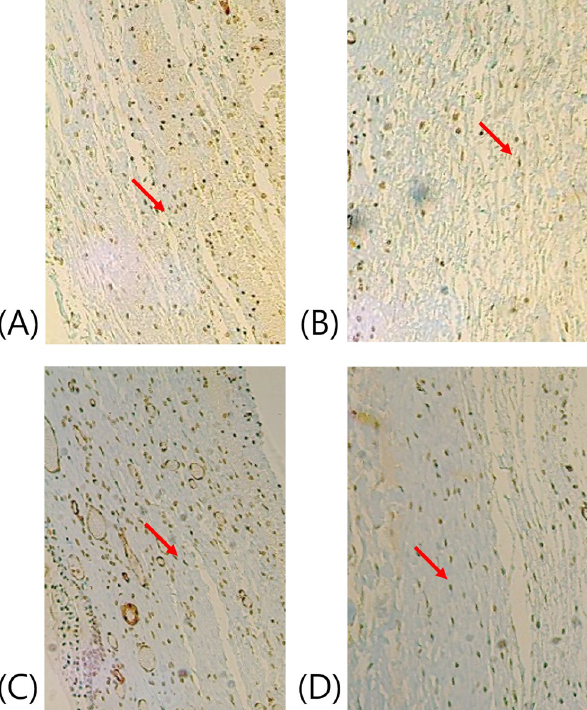
Fig 7. α - Smooth muscle actin staining results. (A) NS = 0.9% normal saline, (B) MMC = 0.5% mitomycin, (C) SR = sirolimus, and (D) TC = tacrolimus. (B and D) The number of myofibroblasts with high α -smooth muscle actin expression reduced in the MMC and TC groups (Light microscopy, 100 × ).